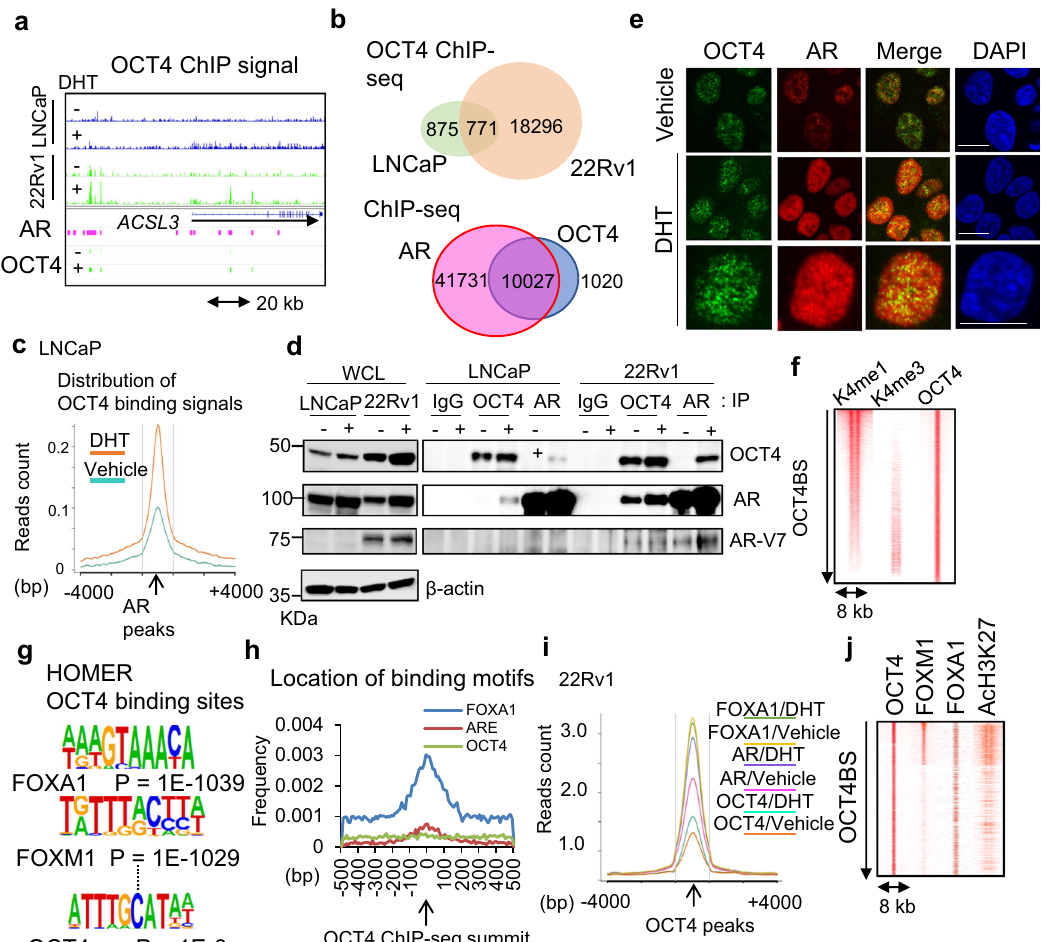
Fig. 2 OCT4 functions as a modulator of AR and FOXA1 TF complex in AR-positive PC cells. a OCT4 ChIP-seq view of a representative AR-target gene, ACSL3 . b (upper) OCT4-binding sites (OCT4BSs) by ChIP-seq in LNCaP and 22Rv1 cells. (lower) Venn diagram showing the overlap of AR with OCT4BSs in the presence of dihydrotestosterone (DHT) in 22Rv1 cells. c Composition plot of OCT4-binding signal in LNCaP cells. d Immunoblots of AR, AR-V7, and OCT4 after immunoprecipitation (IP) in LNCaP and 22Rv1 cells. e Immuno fl uorescence (IF) images of AR and OCT4 in 22Rv1 cells. Bar = 10 μ m. f Heatmap of ChIP-seq signals showing the aligned peaks of active promoter (K4me3) and enhancer (K4me1) markers at OCT4 center. g Motif discovery analysis of OCT4 peak positions (±50 bp). HOMER, publicly available program, was used with the default settings to fi nd the enriched motifs and P -value. h Distribution of FOXA1/AR/OCT motifs around OCT4-binding peaks. i Composition plots of FOXA1 and AR-binding signals around the peaks of OCT4- binding in 22Rv1 cells. j Heatmap of aligned ChIP-seq signals of FOXA1, FOXM1, and AcH3K27 at OCT4 center. Source data are provided as a Source Data fi